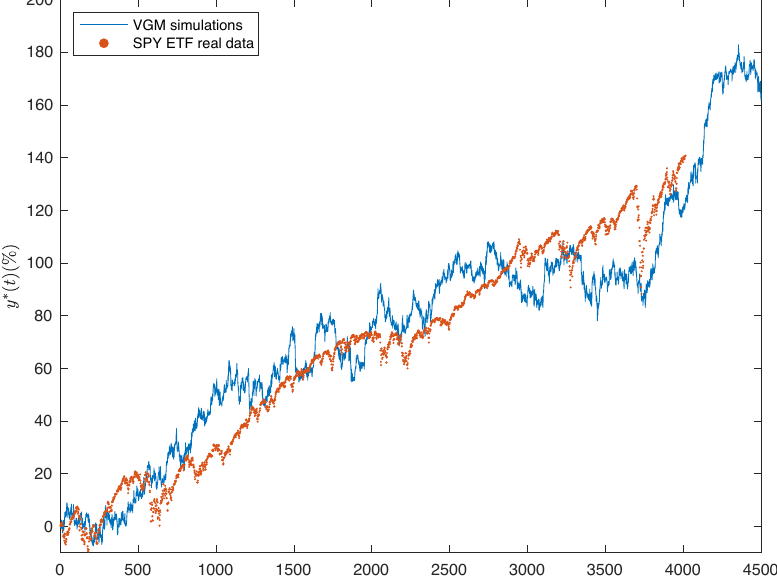
} ) versus SPY ETF data: ˆ µ = 0.0848, ˆ δ = − 0.0577, ˆ σ = 1.0295, t